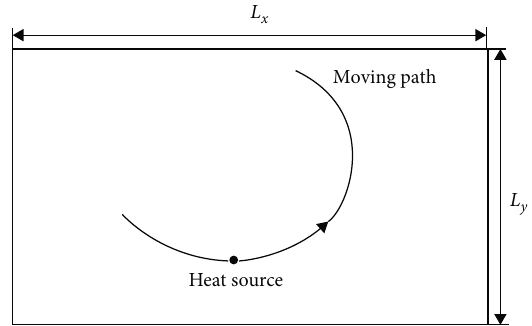
Figure 1: Sketch of the rectangular plate with a moving point heat